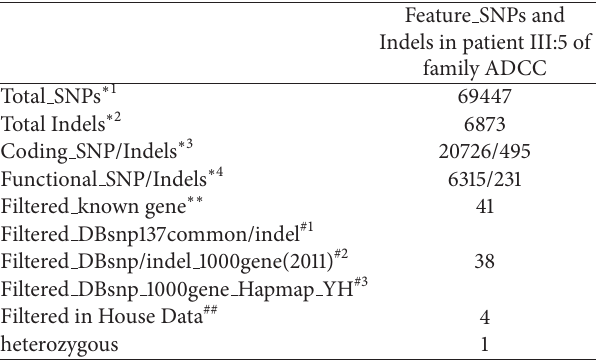
Table 2: Number of candidate SNPs/Indels filtered against several public variation databases and the in-house data.